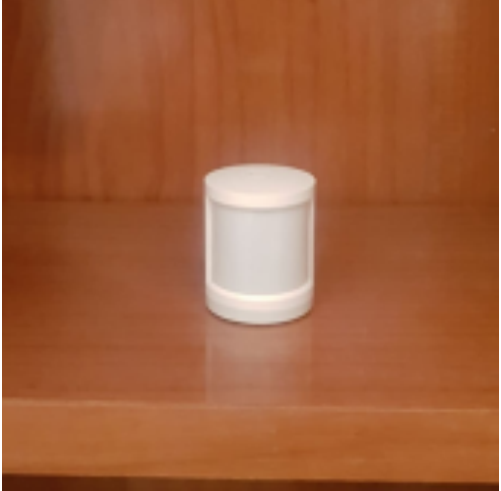
Figure 20. PIR-type movement sensor to detect presence in a